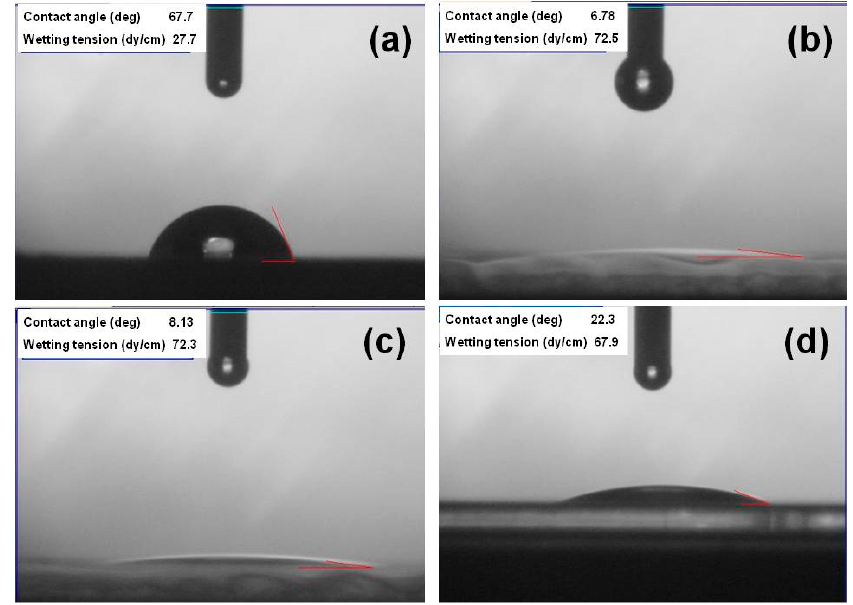
Figure 1. Contact angles of polyimide (PI) substrates with different O 2 pretreatment times: ( a ) 0 s, ( b ) 60 s, ( c ) 120 s, and ( d ) 420 s.